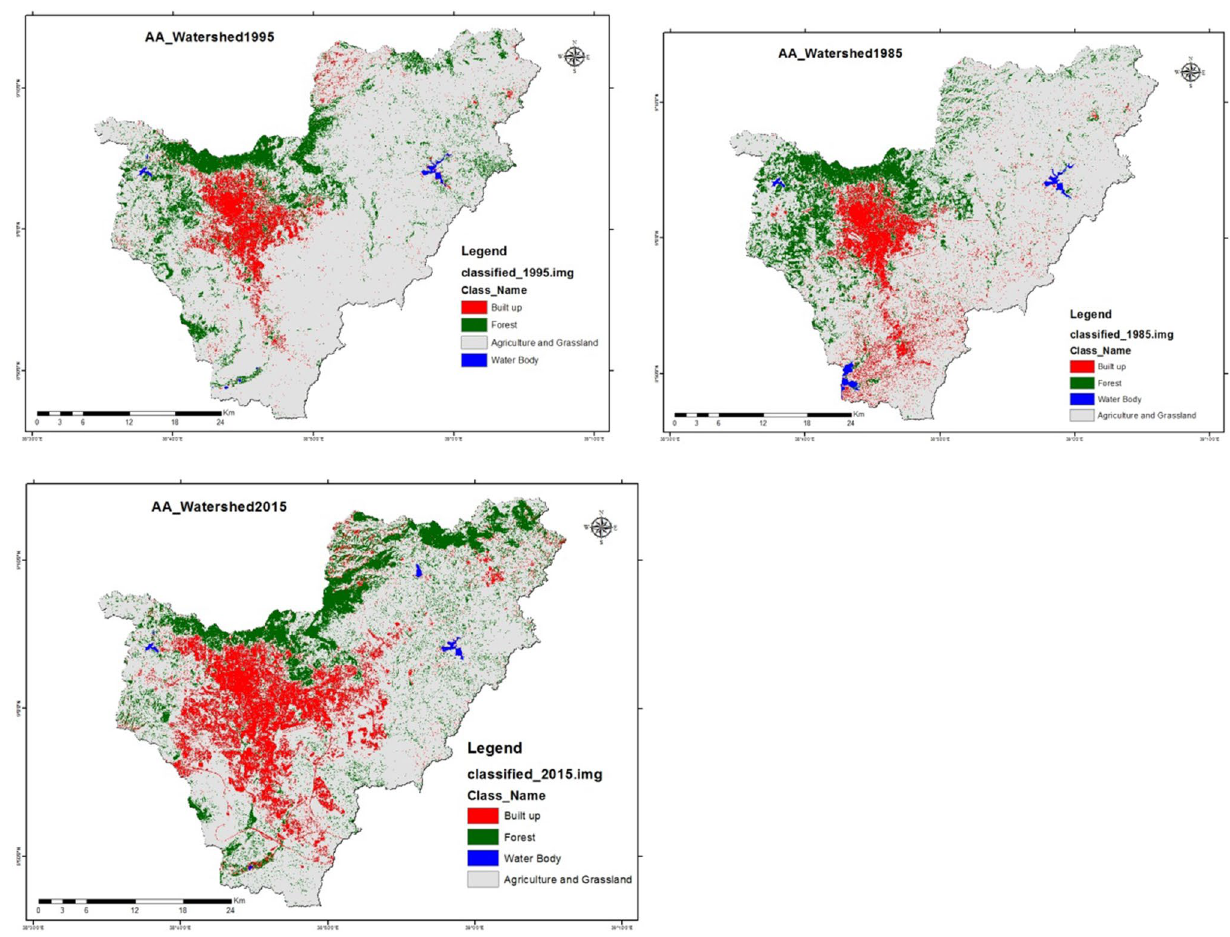
Fig. 8 Classified maps of land use and land cover of the major/large watershed of the Aba-Samuel reservoir. Source Addis Ababa Rivers, River- sides Climate Change Adaptation Project Office 2017a, b,